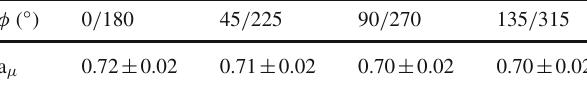
Table 1 Muon-attenuation factor, a μ , at the VNS for different azimuthal angles φ . φ and φ + 180 ◦ are considered as one orienta- tion. Only statistical uncertainties are considered